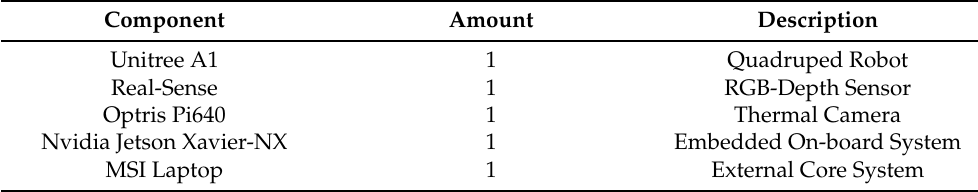
Table 1. Evaluation of the neural network